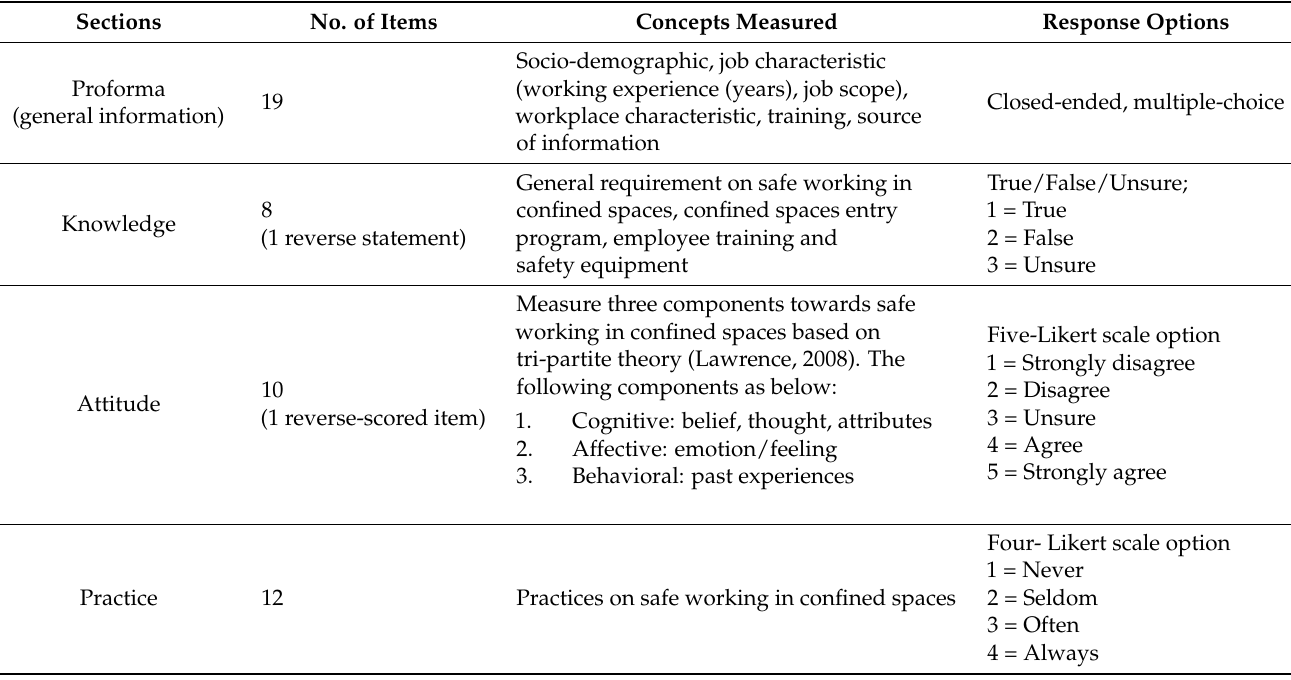
Table 1. CS-KAP questionnaire on safe working in confined